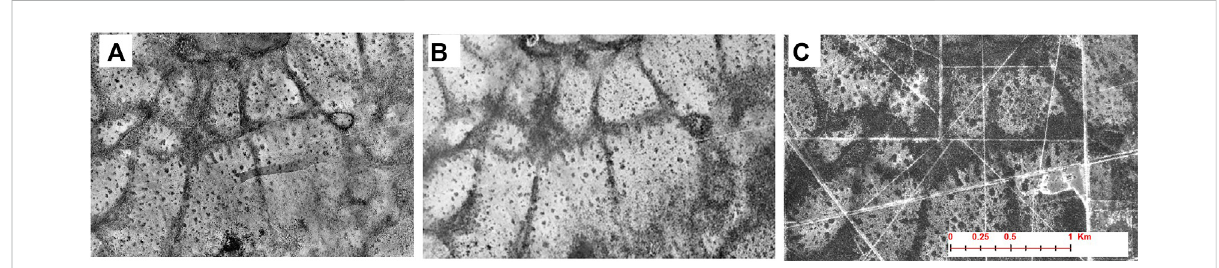
FIGURE 4 AerialimageryshowingchangesovertimeinthestudysiteforCaseStudy3(SouthTexasShrublands) (A) 1930; (B) 1955;and (C) 1995.Notethat woody vegetation is increasing with time and expanding from the drainage ways to the upland portions of the